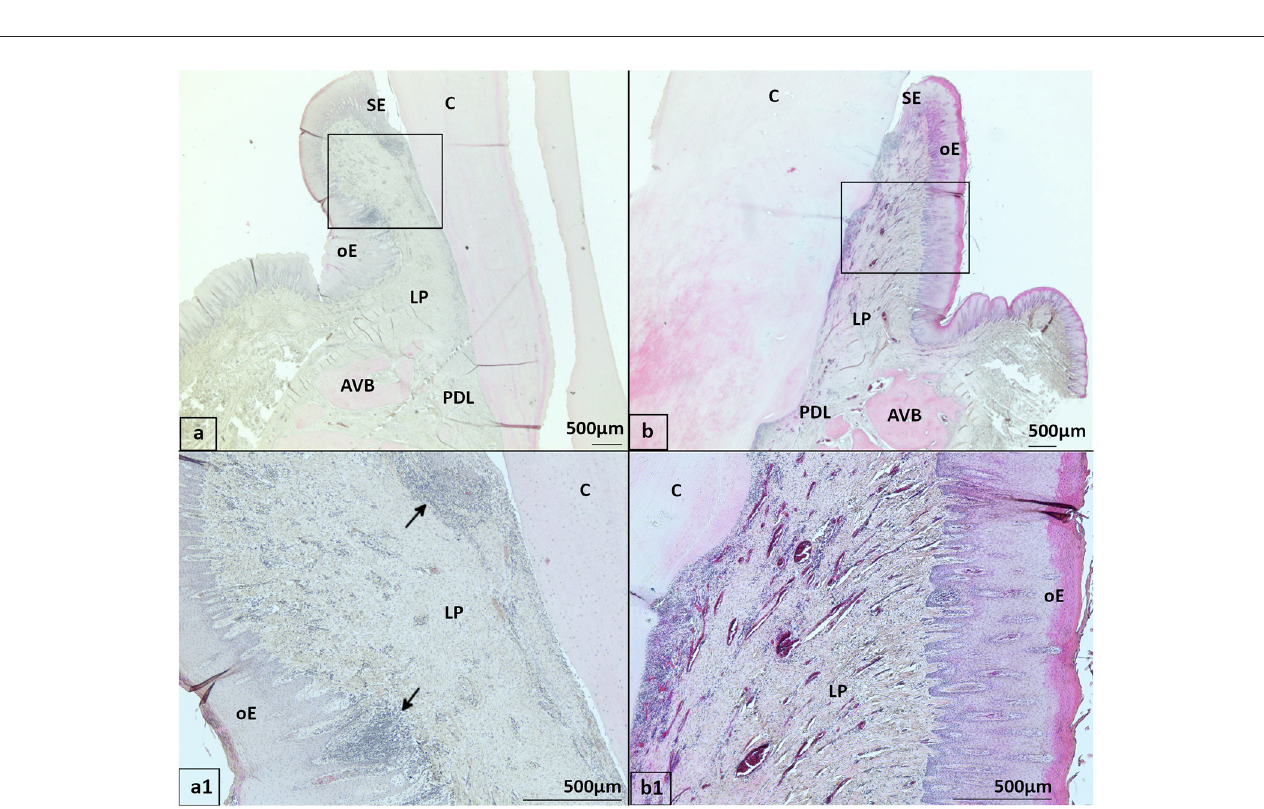
FIGURE4 Distribution of leukocyte infiltrations (LI) in gingiva, HE stained (a, a1) 20-year-old Icelandic control mare, 409 buccal aspect with multifocal LI (arrows) in gingiva close to the gingival sulcus and oral epithelium. (b, b1) 29-year-old Warmblood gelding with PPID, 408 buccal aspect with multifocal to coalescing LI in the gingiva. oE, Oral epithelium; SE, Sulcular epithelium; LP, Lamina propria; PDL, Periodontal ligament; AVB, Alveolar bone; C, Cementum.